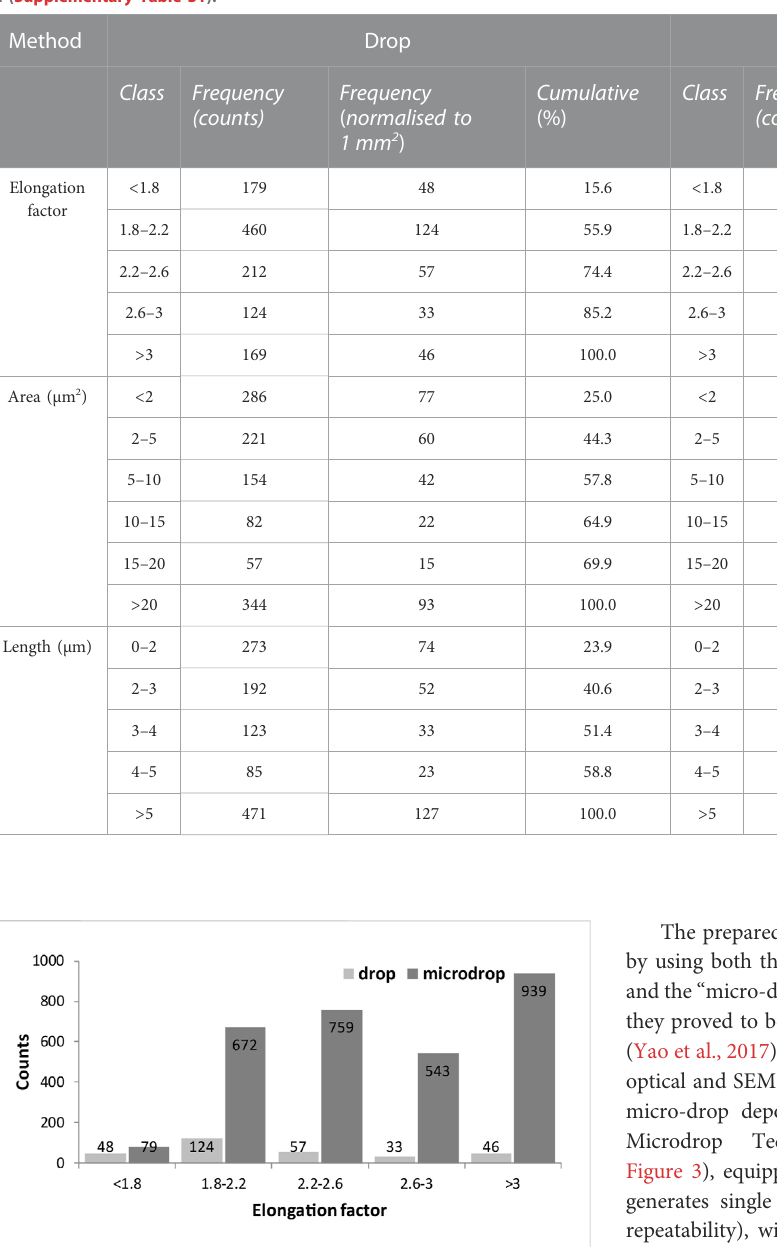
FIGURE 6 Histograms showing the elongation factor (EF, length/width) of the identi fi ed objects for both drop and microdrop deposition methods, respectively. The class of objects with EF > 3 contains fi bres according to AIA guidelines. Counts are normalised to mm 2